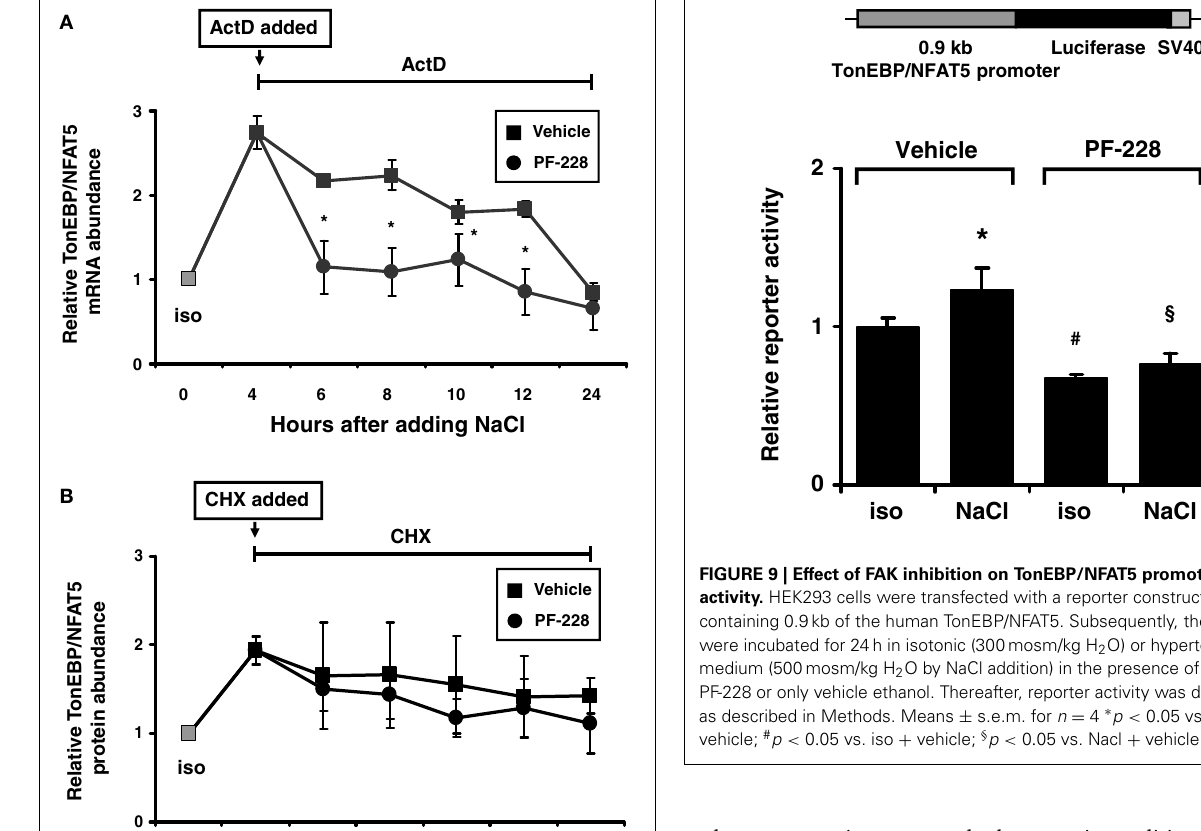
and osmoprotective genes under hypertonic conditions (Moeckel et al., 2006). Accordingly, mice deficient for integrin α 1